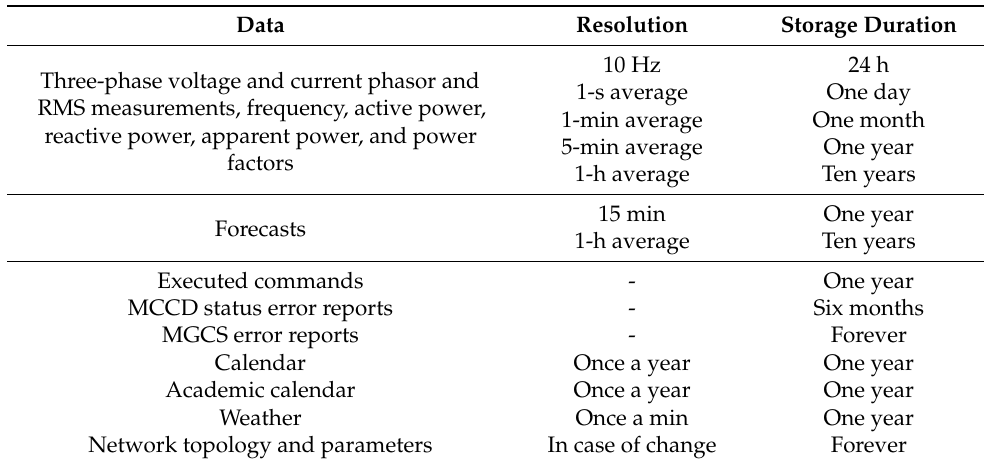
Table A1. The storage strategy in the database module.